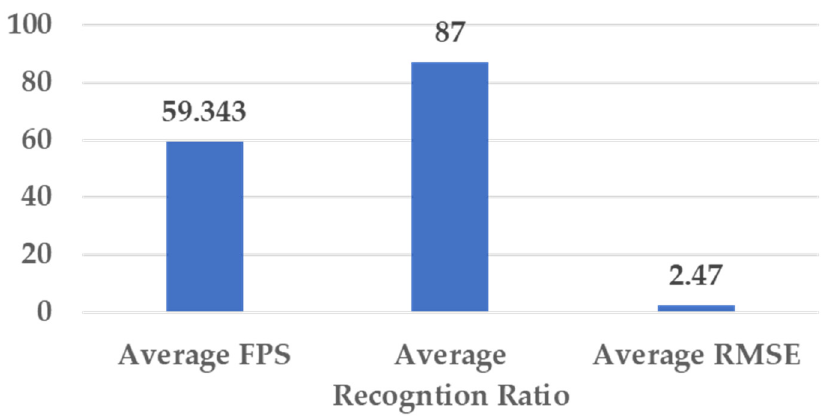
Figure 17. Results of the average points of the questionnaires for the evaluation of user interaction.